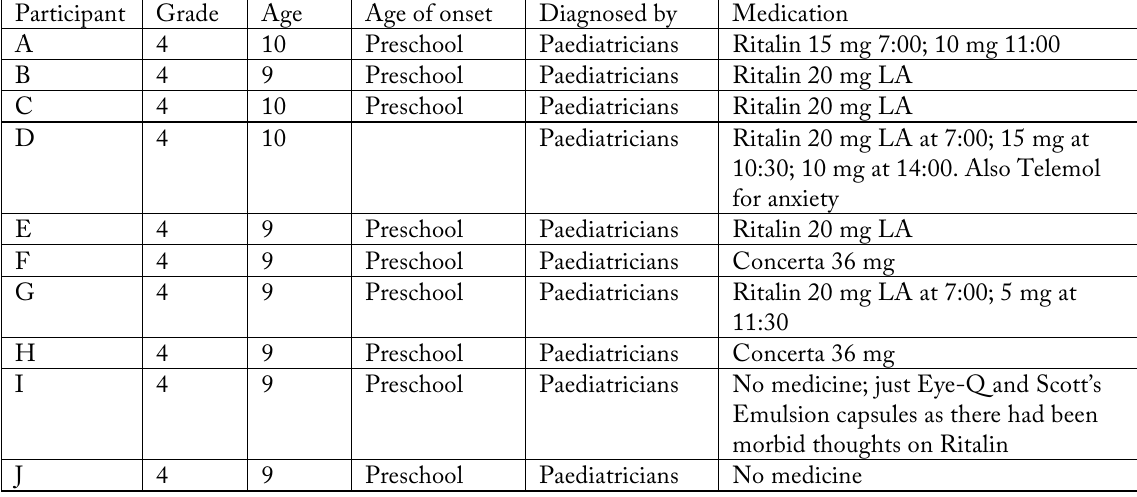
Biographical details of